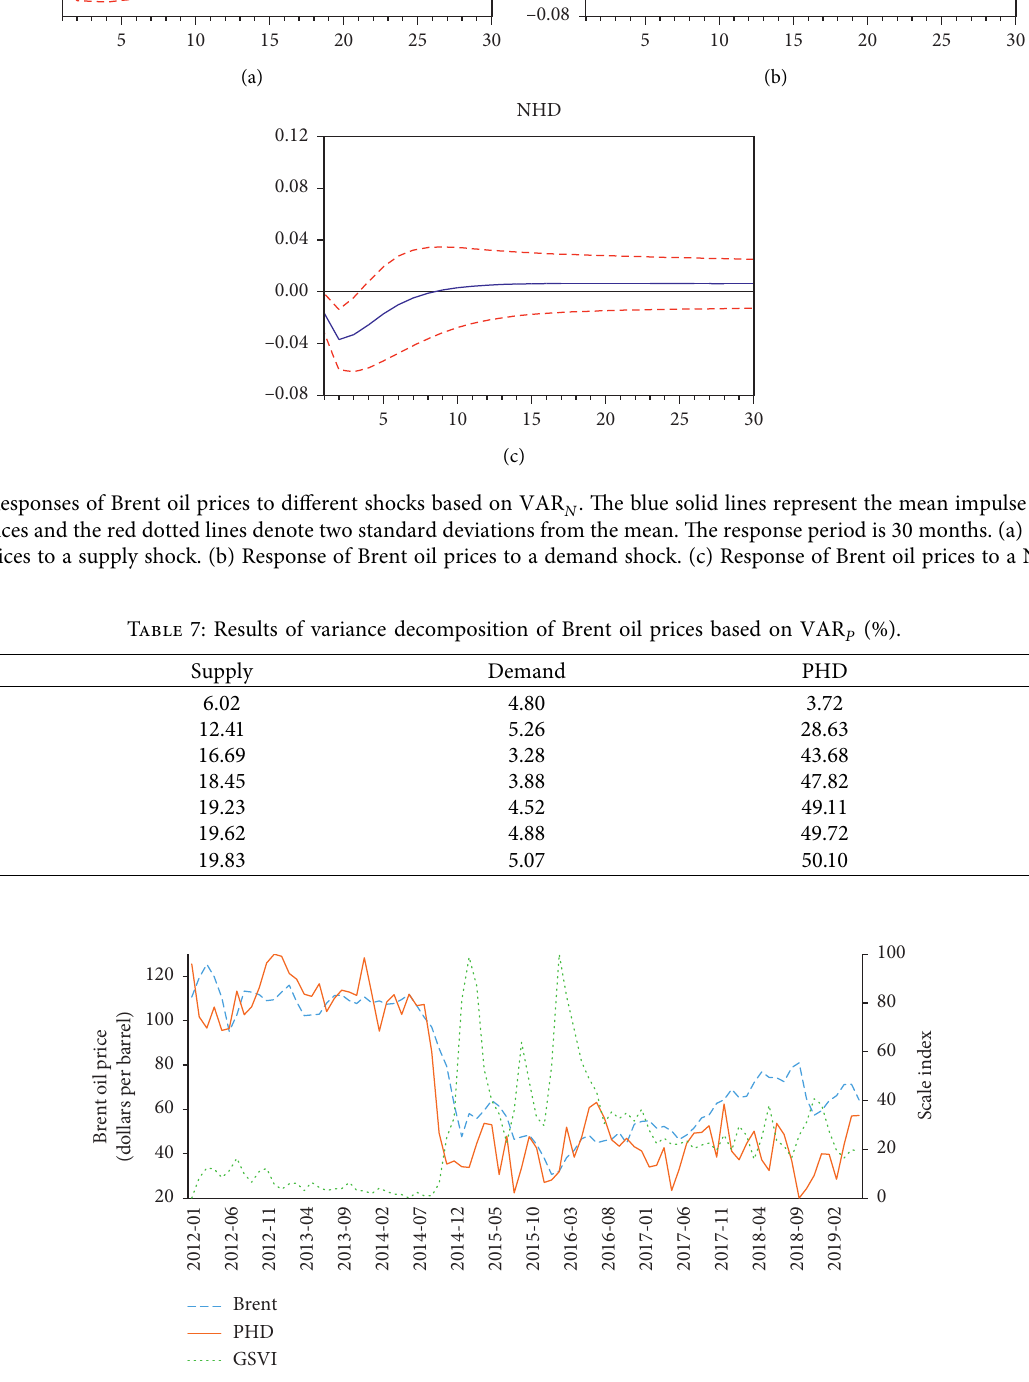
Figure 6: Comparison of oil prices, PHD, and Google trends.